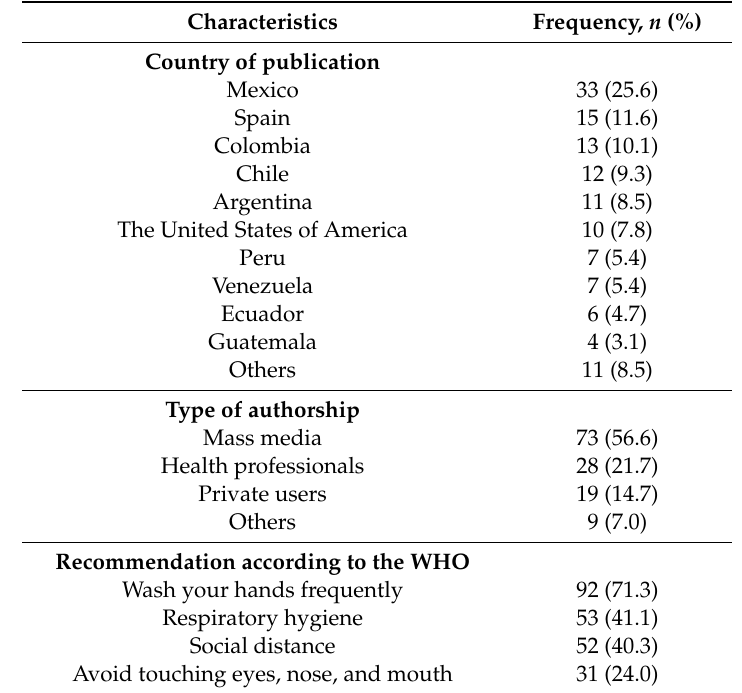
Table 1. Characteristics of the 129